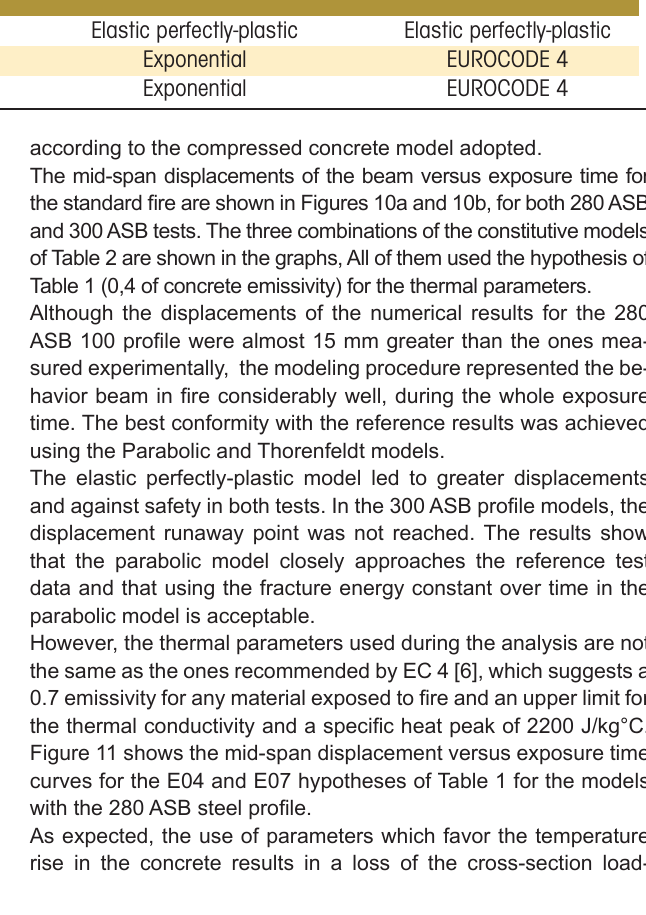
Compressed concrete